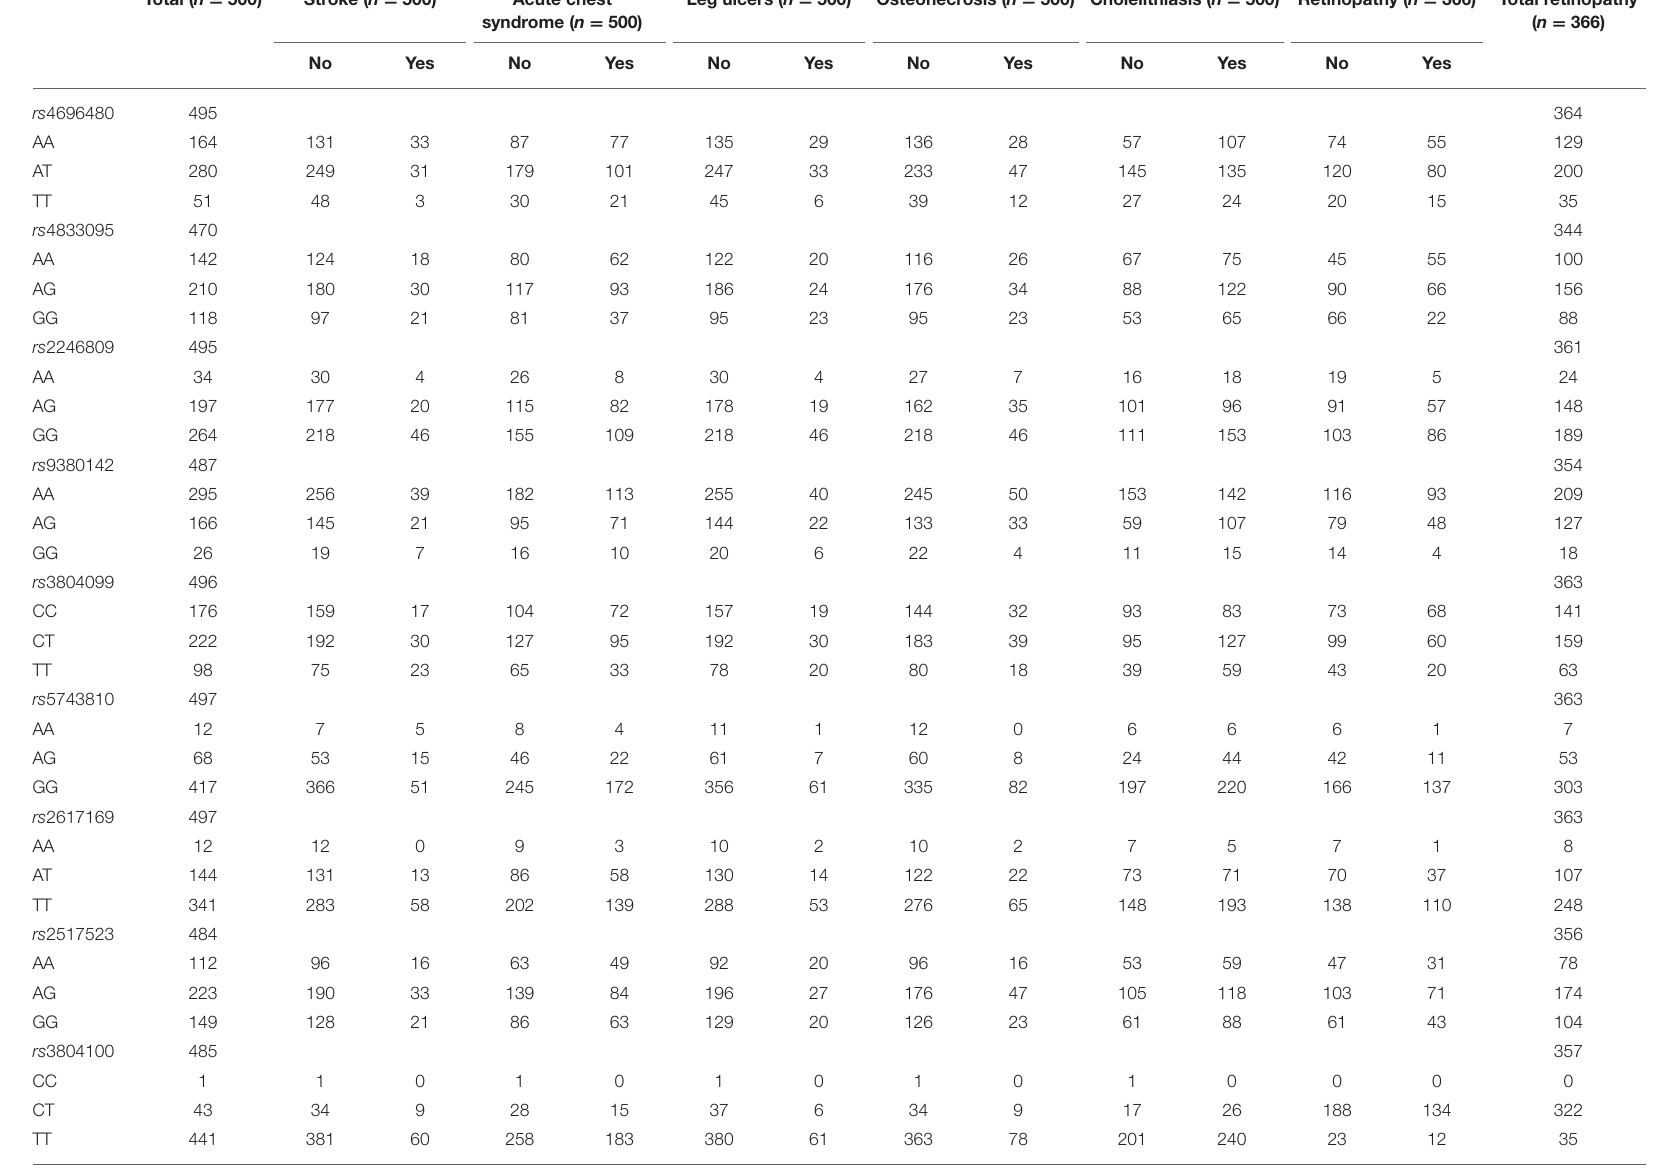
TABLE 2 | Genotype distribution for each SNP in the study population and according to clinical